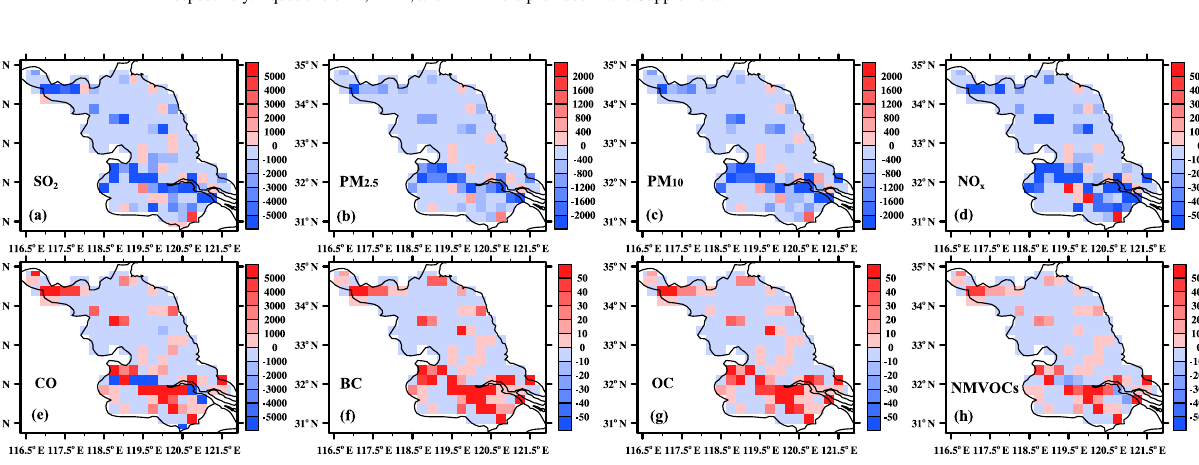
Figure 2. Differences in power plant emissions between MEIC and UEIPP in 2012 (units: tons).